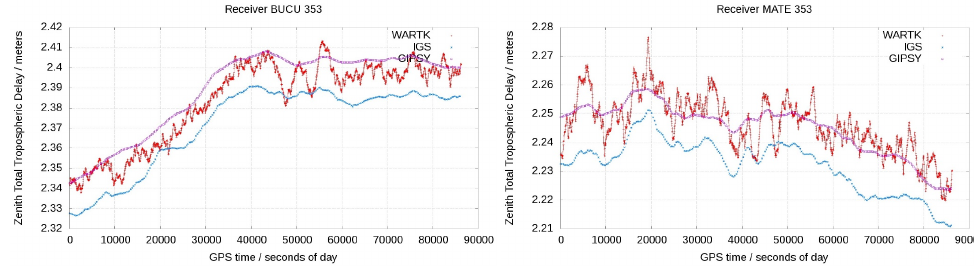
Figure 3. ZTD computed by WARTK TOMION (red), GIPSY (magenta) and IGS (blue) for BUCU (Romania) and MATE (Italy) GNSS receivers from IGS GNSS